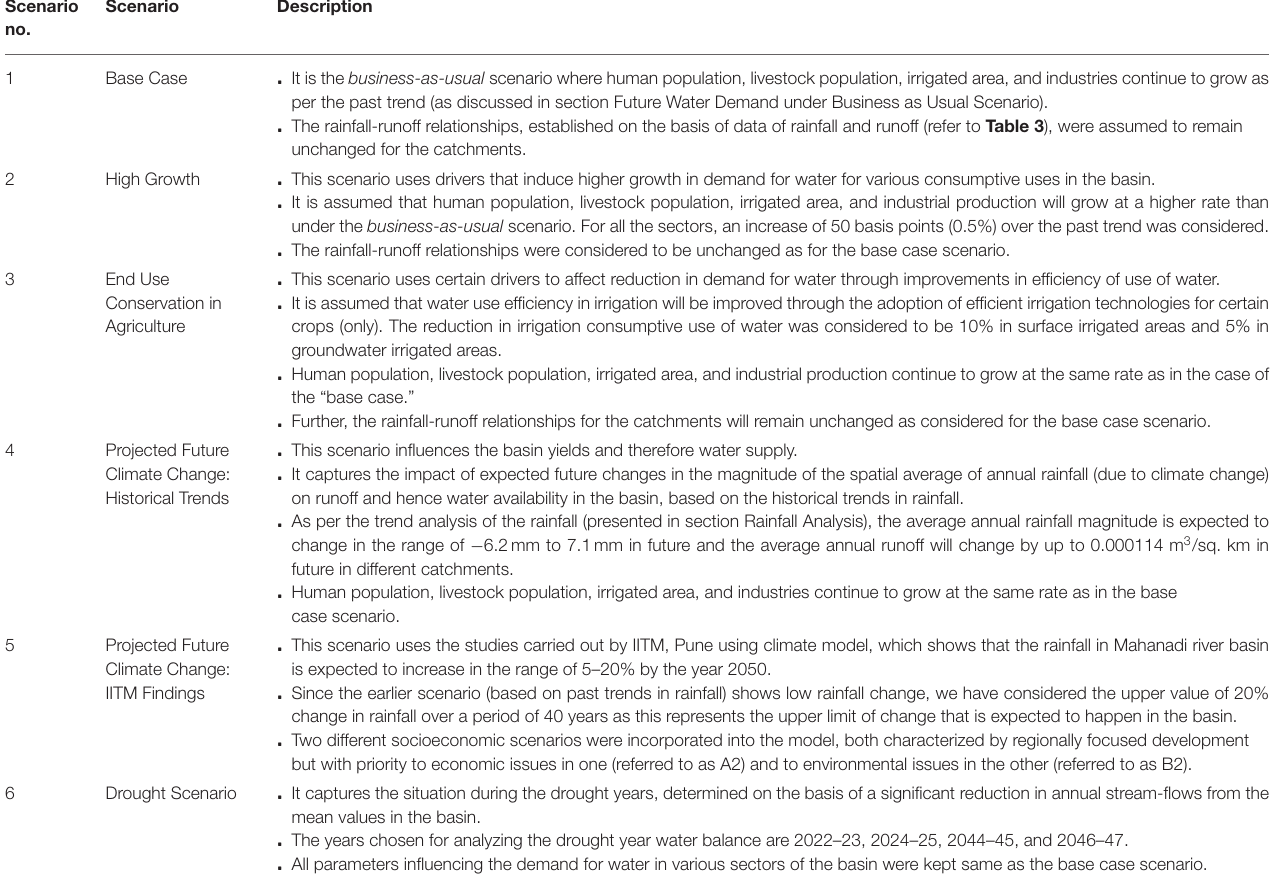
TABLE 4 | Future water balance scenarios modeled using WEAP. Scenario